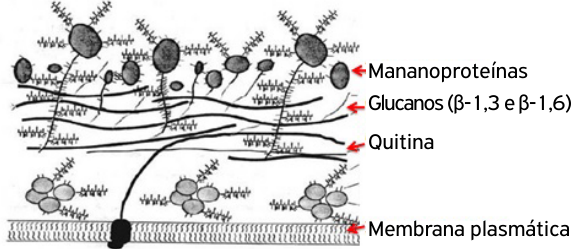
Fonte: adaptado de Gomes (2002).